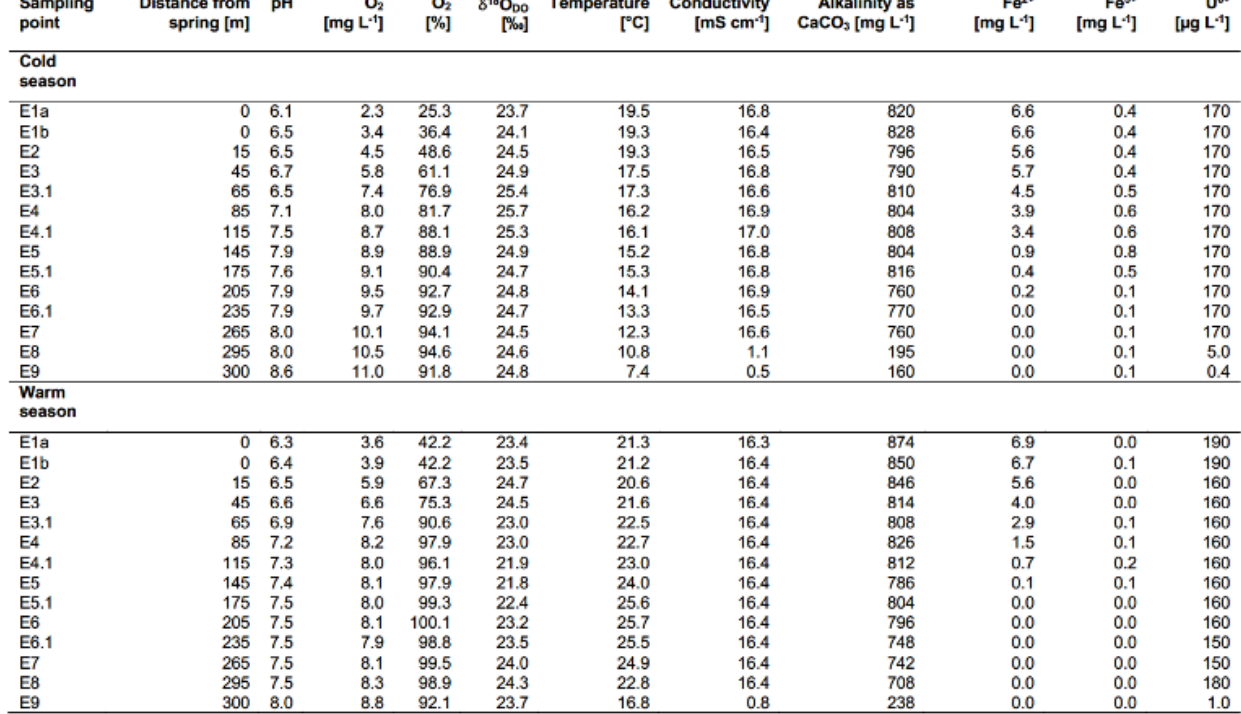
Table 1. Field parameters, δ 18 O DO values, iron and uranium from sampling campaigns in February (cold season) and May (warm season)